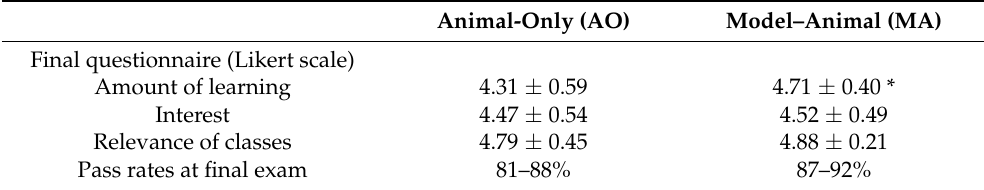
Table 1. Comparison between students enrolled in the animal only system (AO), corresponding to 110 students from N1(2018/19) and N2(2019/20), and the students using the model–animal (MA) approach, comprising 121 students from N3(2020/21) and N4 (2021/22).